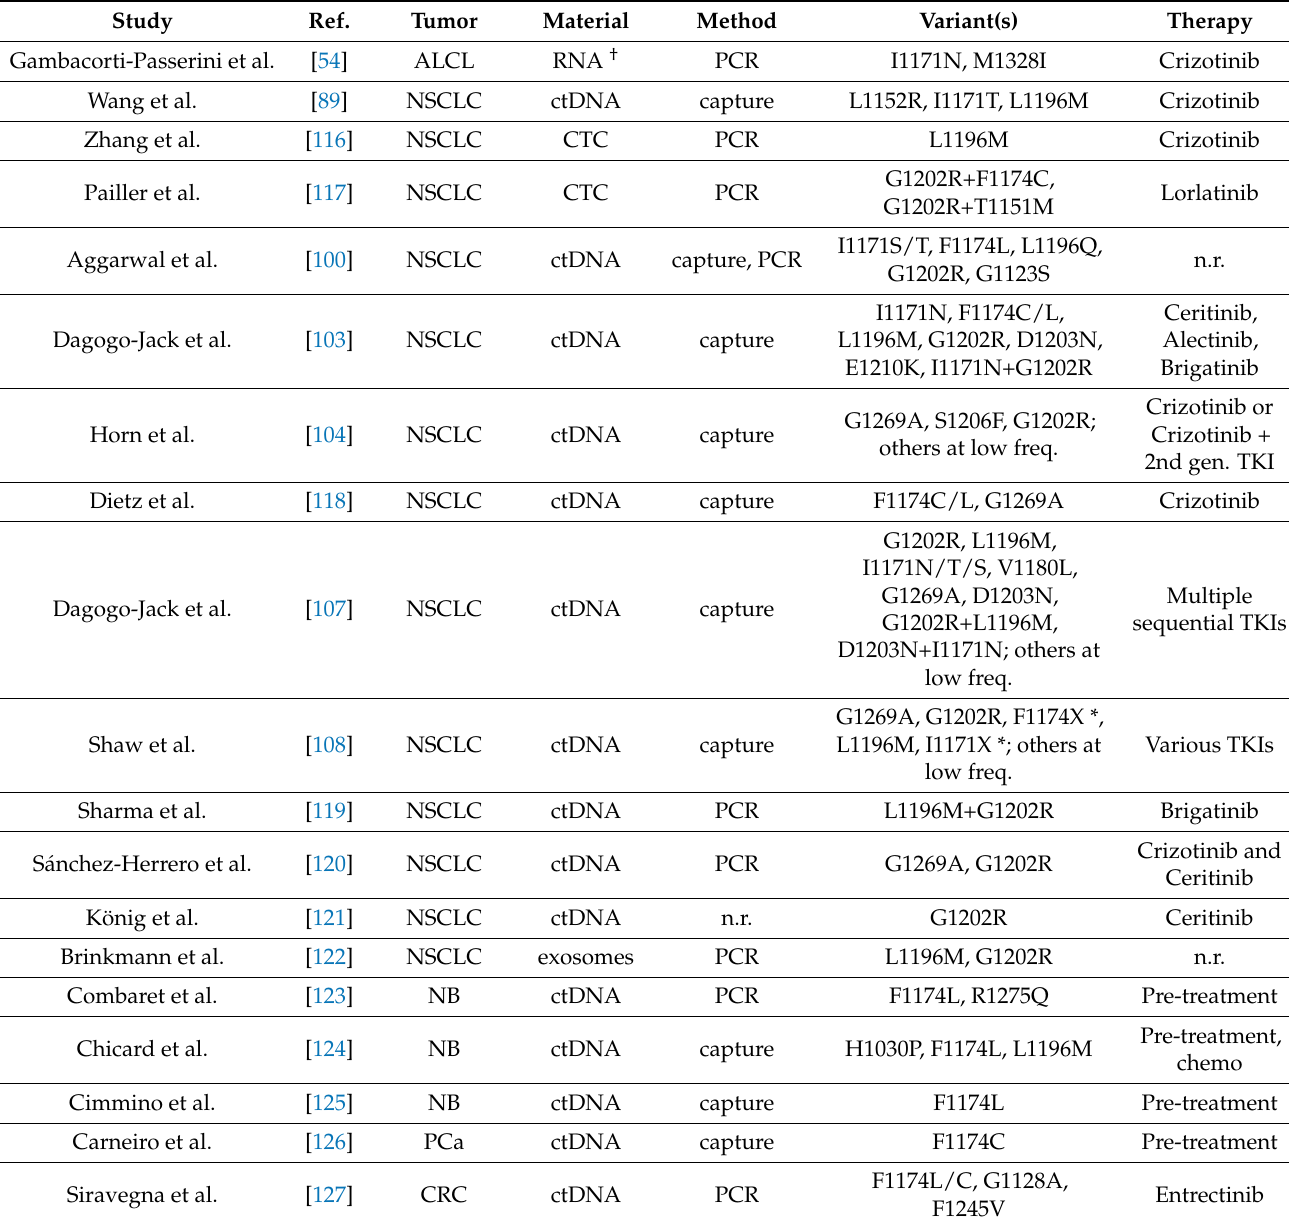
Table 2. ALK mutational data obtained by liquid biopsy in various